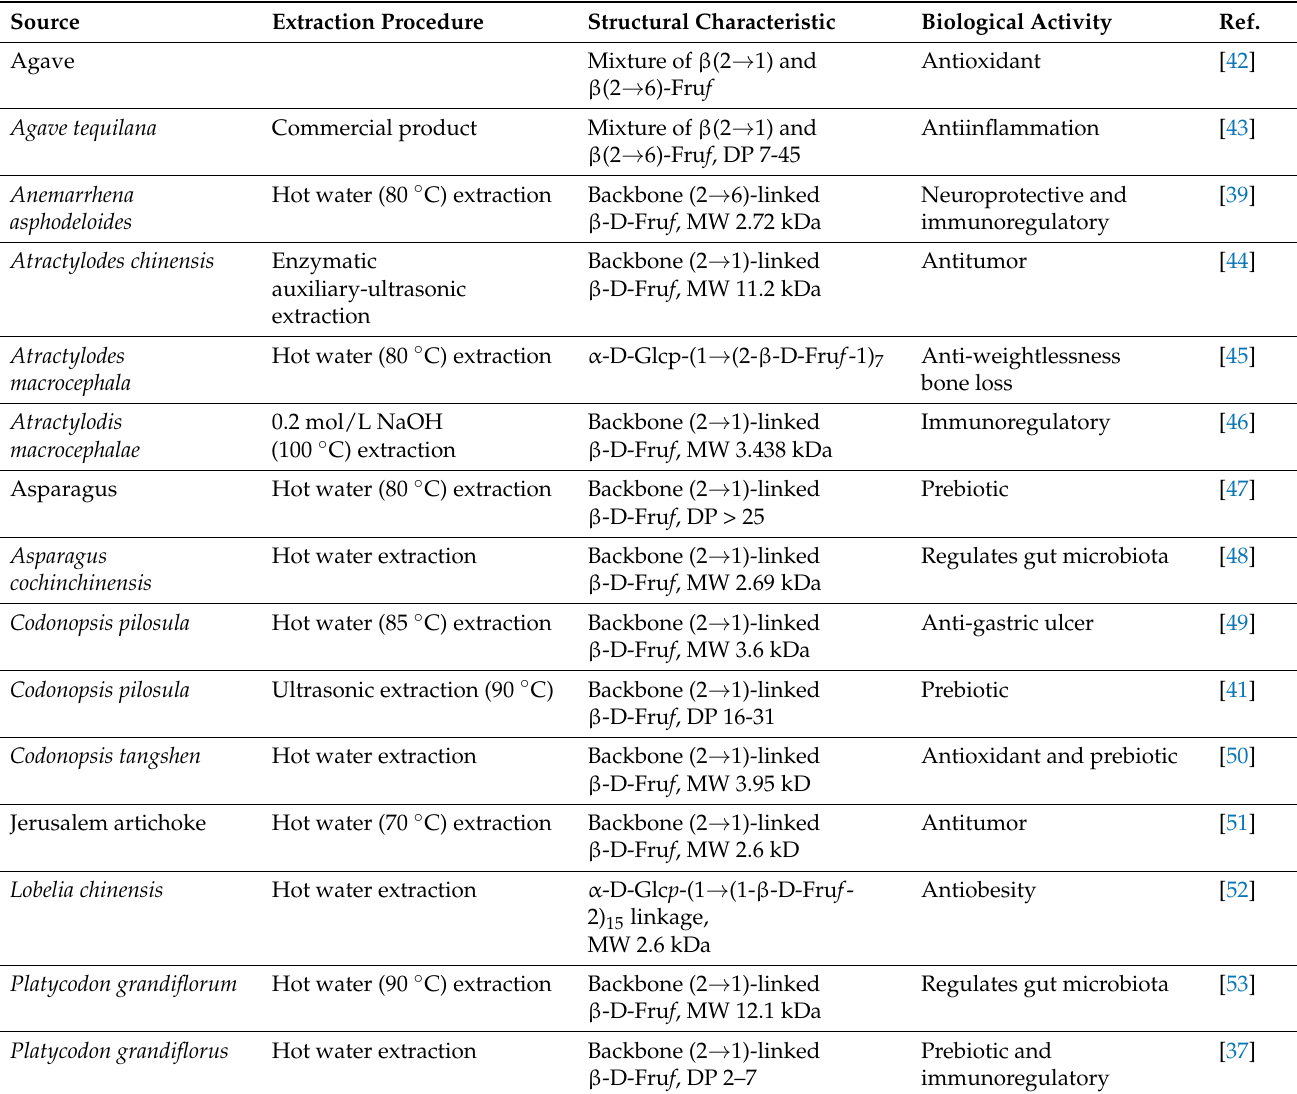
Table 2. Extraction procedures, structural characteristic, and the biological activity of